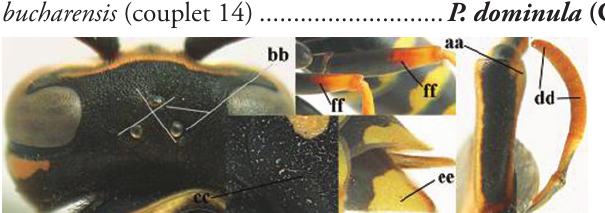
– Scapus distinctly widened apically in dorsal view (aa); ocellar triangle trans- verse (bb); change in sculpture between mesepisternum and epicnemium abrupt (cc; = epicnemial ridge distinct); apical half of antenna orange or yel- low (dd); apical half of hypopygium yellow or largely so and as pale as apex of apical tergite (ee), rarely darker; border of black and yellow on outer side of middle and hind femora washed out, partly because of orange intermediate area (ff); somewhat larger species); Europe except N, NW Africa, W and C Turkey, Azerbaijan, probably also farther east in temperate Asia. Not in Crete, see P. bucharensis (couplet 14) ........................... P. dominula (Christ, 1791)